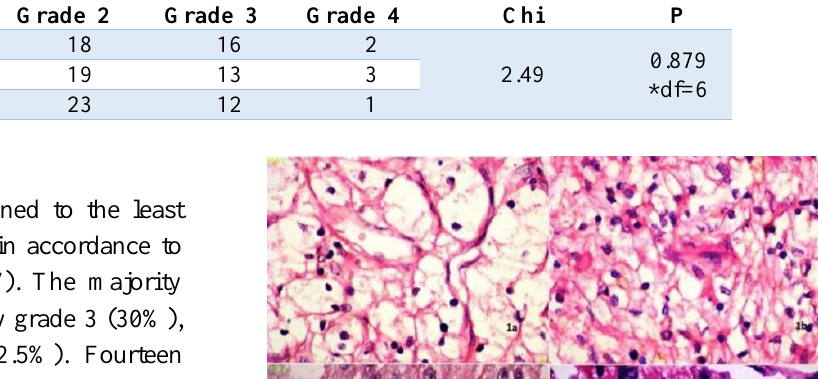
Table 1. Fuhrman Nuclear Grading of Clear Cell Renal Cell Carcinoma by Two Observers and Final Grading With Consensus Observers